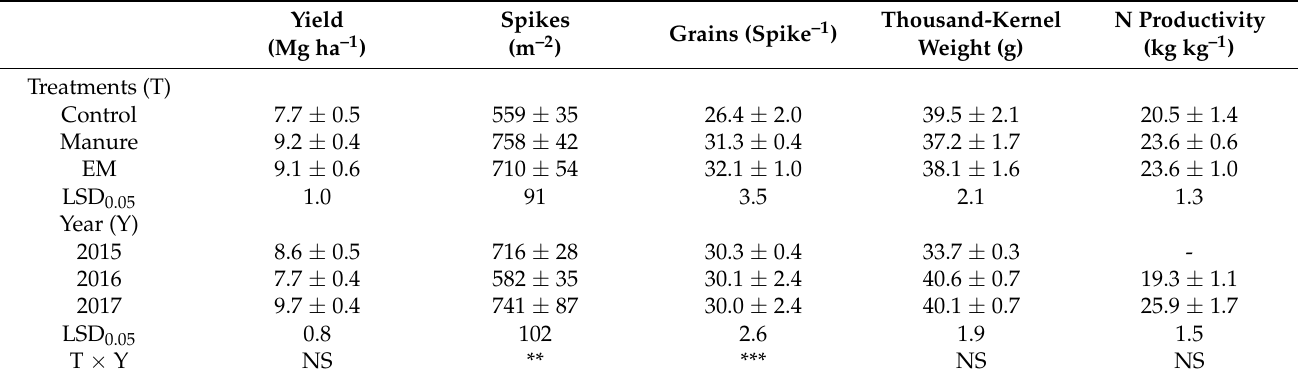
Table 3. Wheat yield, yield components, and N productivity for the three treatments from 2015 to